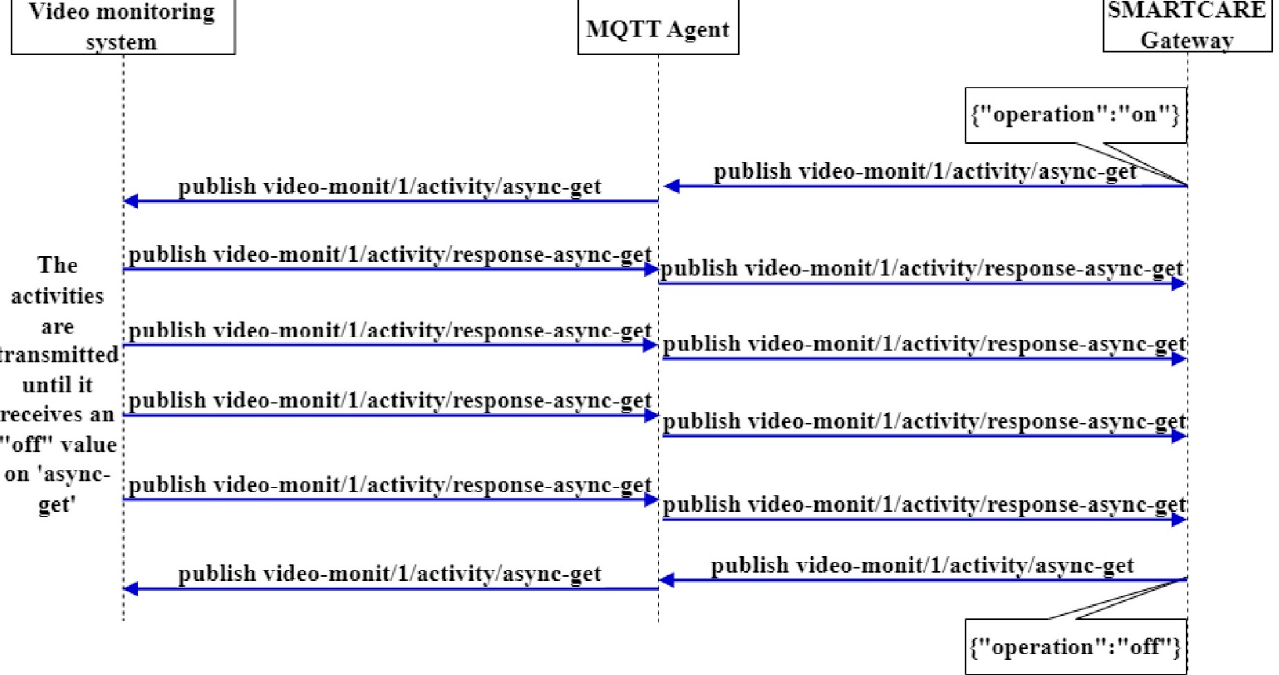
Figure 14. Asynchronous communication between the HAR module and the SmartCare system.